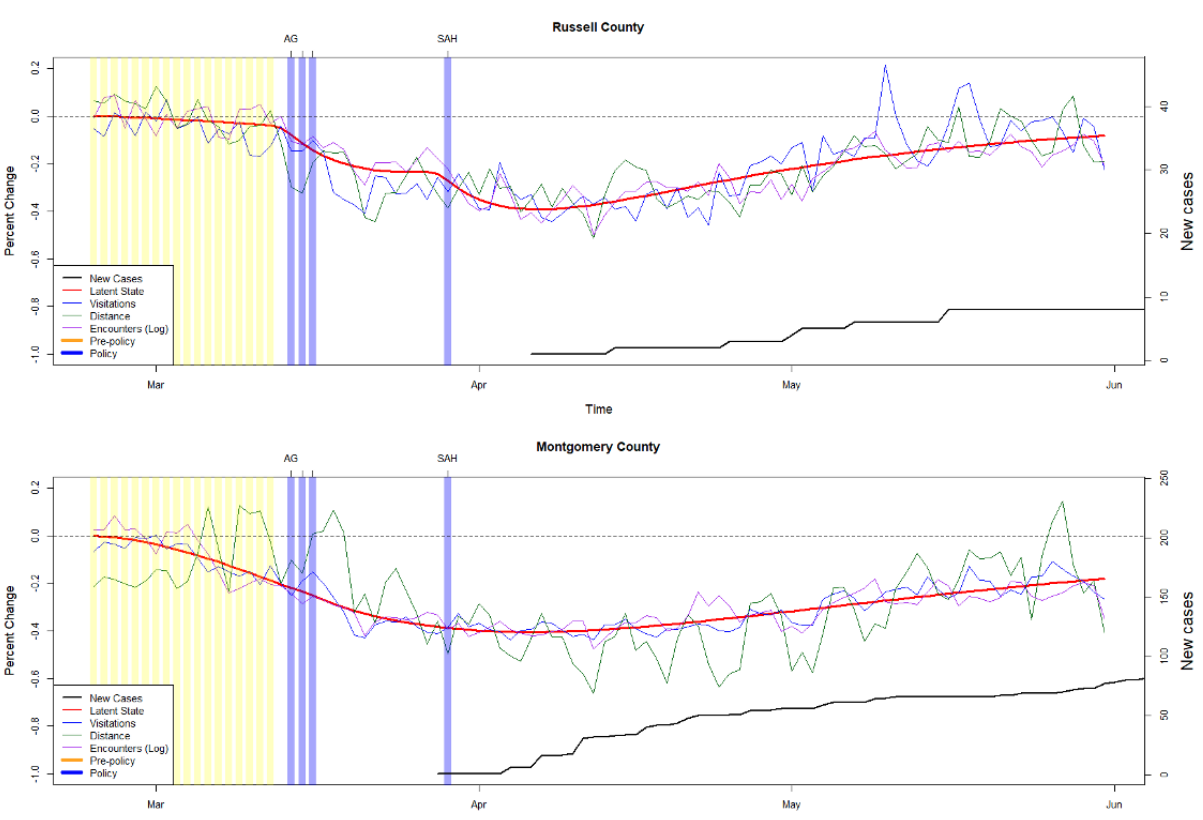
Figure 1. Two examples of social distancing behavior by county with estimated dynamics and policy effects. Top: One county shows no pre-policy distancing followed by inflections at the dates of major policies. Bottom: Distancing was driven almost entirely by pre-policy behavior; policy had little to no effect. The Virginia policies shown in order were restrictions on all large gatherings (AG), closure of all businesses (AB), closure of all educational facilities (EF), and stay-at-home orders (SAH).